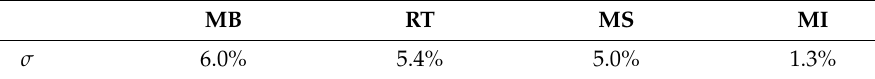
Figure 6. Velocity comparison. Table 2. The difference between the reference and estimated velocities.